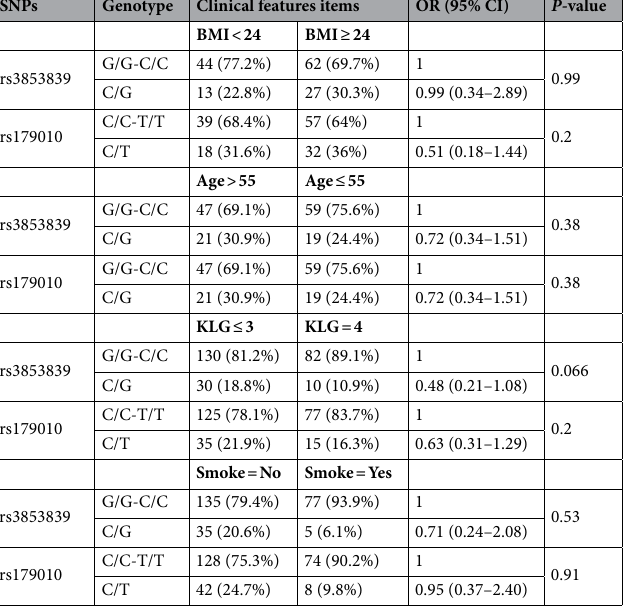
SNPs Genotype Clinical features